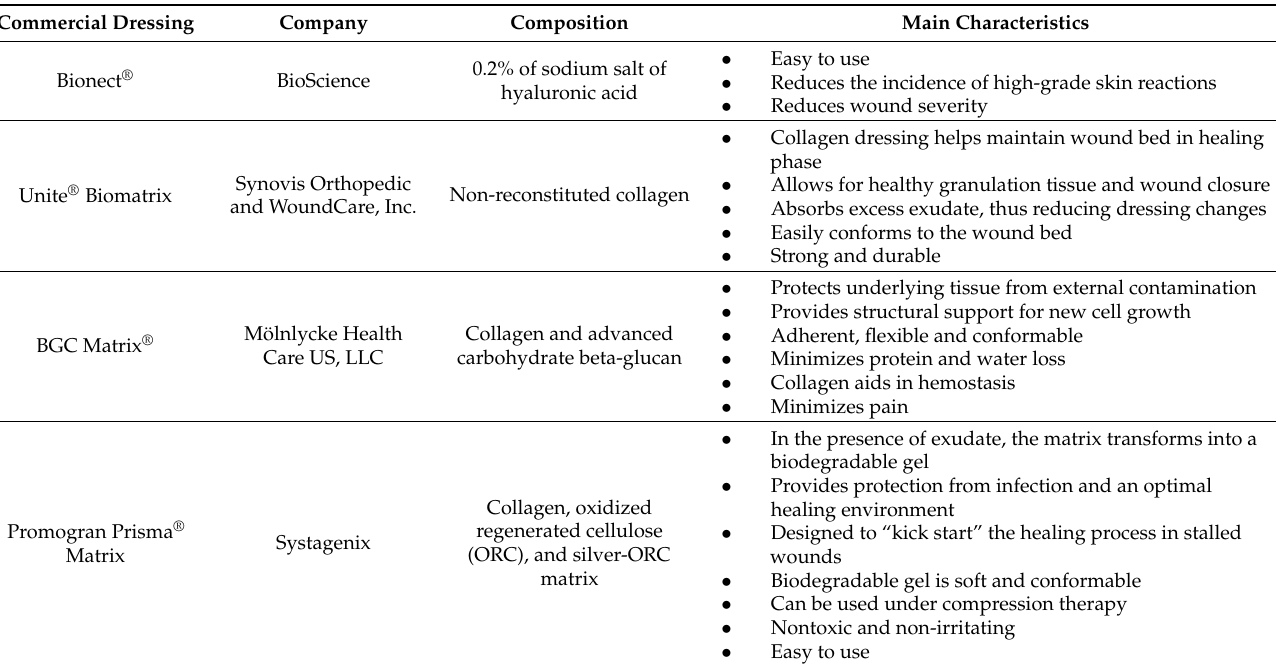
Table 1. The typical examples of commercially available topical wound dressings for DFU 1